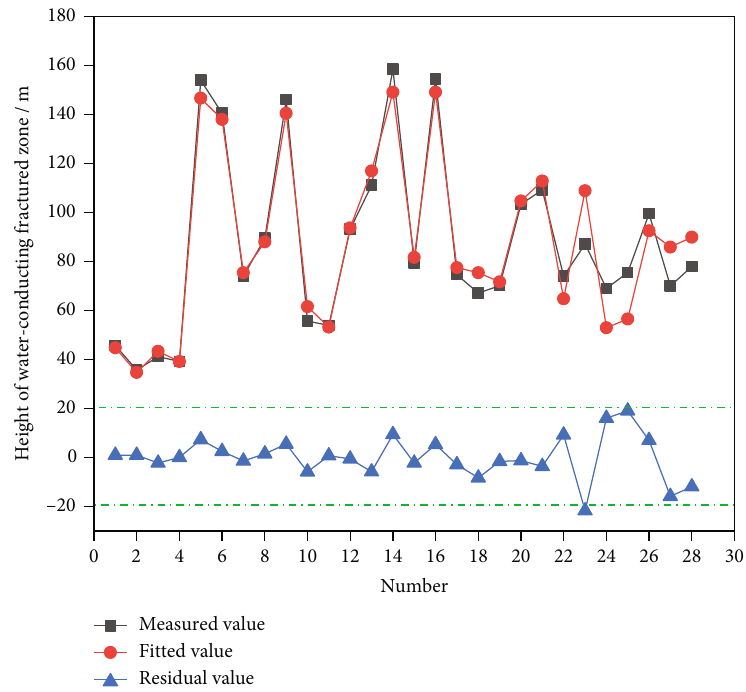
Figure 6: Residual error analysis of prediction formula. Table 2: Empirical formula of the height of the water-conducting fracture zone [14]. Lithology Formula (1)/m Formula (2)/m